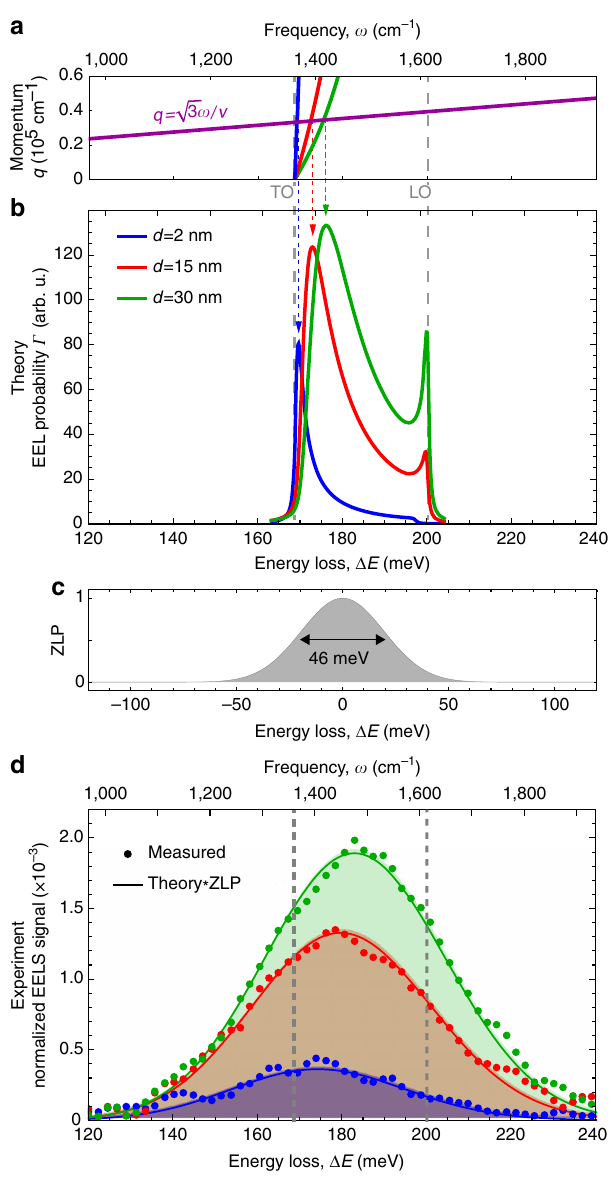
Fig. 4 Thickness dependence of h-BN EEL spectra. a Dispersions (low energy part) of the fundamental M0-HPhP mode in h-BN fi lms of 2 nm ( blue ), 15 nm ( red ), and 30 nm ( green ) thicknesses. Blue , red , and green vertical dashed lines mark the energies at which these dispersion curves ffiffiffi p ω = v ( purple line ), and which determine the intersect the line q ¼ 3 positions of spectral maxima of Γ guid ( ω ). b Theoretically calculated EEL probability for the corresponding fi lm thicknesses. c A Gaussian with FWHM = 46 meV representing the experimental ZLP. d Experimental spectra ( dots ) of h-BN averaged over areas marked by blue , red , and green boxes in Fig. 1a. The shaded curves are theoretical EEL spectra obtained by convolving spectra of b with the ZLP in c . All calculated spectra were scaled by the same factor to correspond with the experiment. In all plots, the left and right vertical dashed lines mark the TO and LO phonon energies,